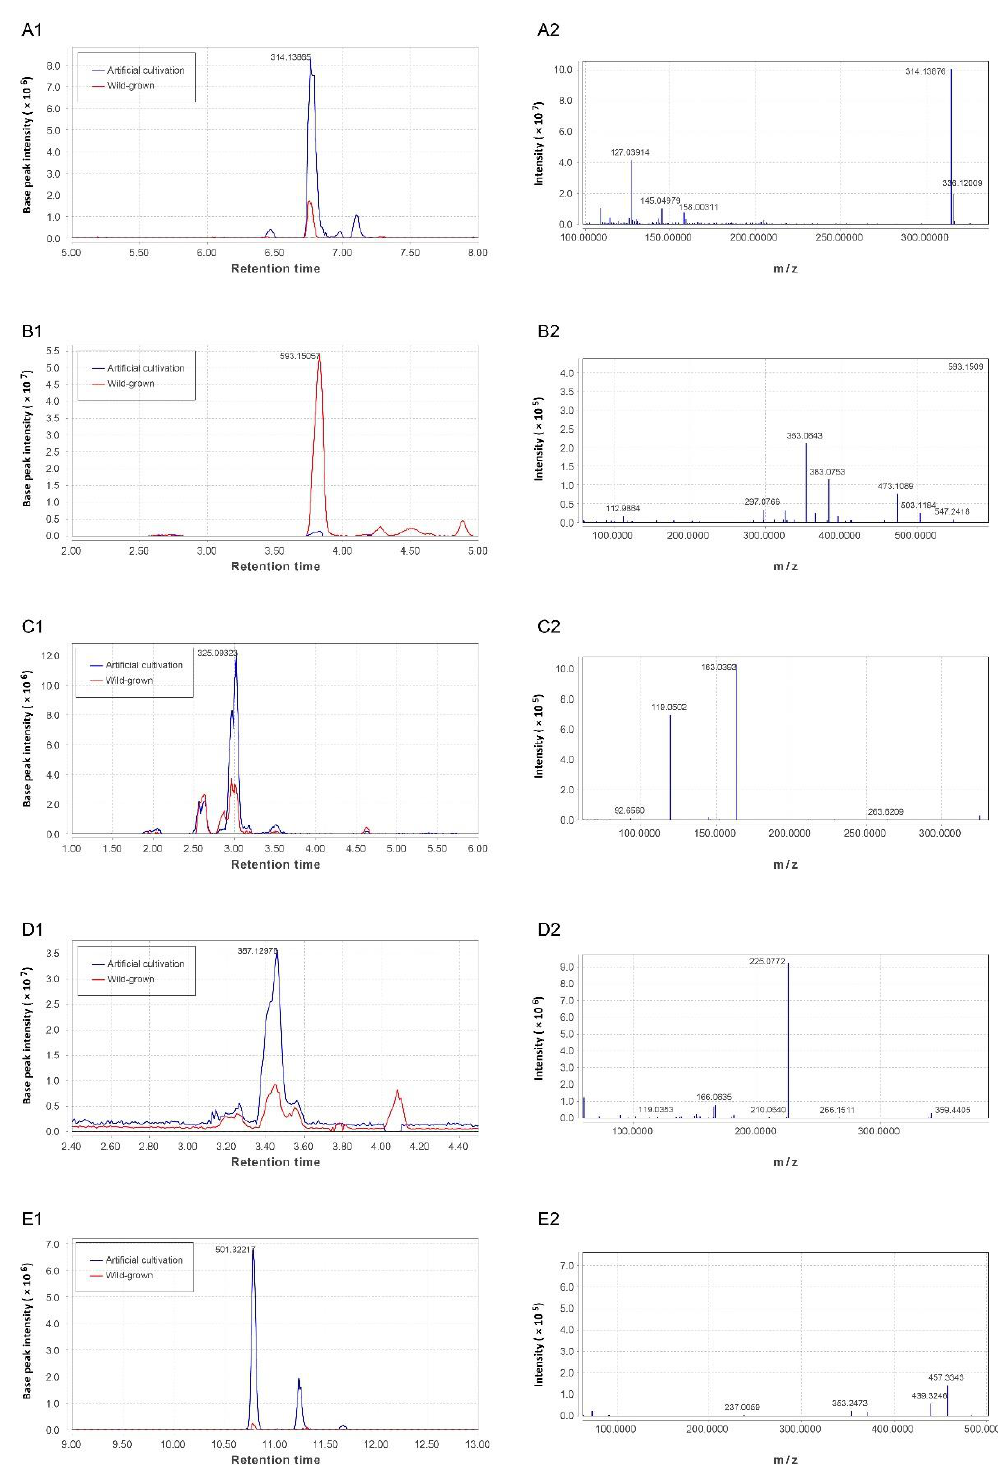
Figure 6. The extract ion chromatograms and data-dependent MS2 fragmentation spectra of repre- sentative phytochemical compounds. The extract ion chromatogram at m / z 314.13865 in positive ionization mode ( A1 ) and its MS2 fragmentation spectrum ( A2 ). The extract ion chromatogram at m / z 593.15057 in negative ionization mode ( B1 ) and its MS2 fragmentation spectrum ( B2 ). The extract ion chromatogram at m / z 325.09323 in negative ionization mode ( C1 ) and its MS2 fragmentation spectrum ( C2 ). The extract ion chromatogram at m / z 387.12978 in negative ionization mode ( D1 ) and its MS2 fragmentation spectrum ( D2 ). The extract ion chromatogram at m / z 501.32217 in negative ionization mode ( E1 ) and its MS2 fragmentation spectrum ( E2